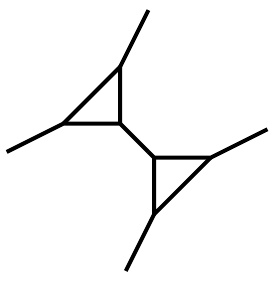
Figure 16 . A 5-brane web for the connecting two E 0